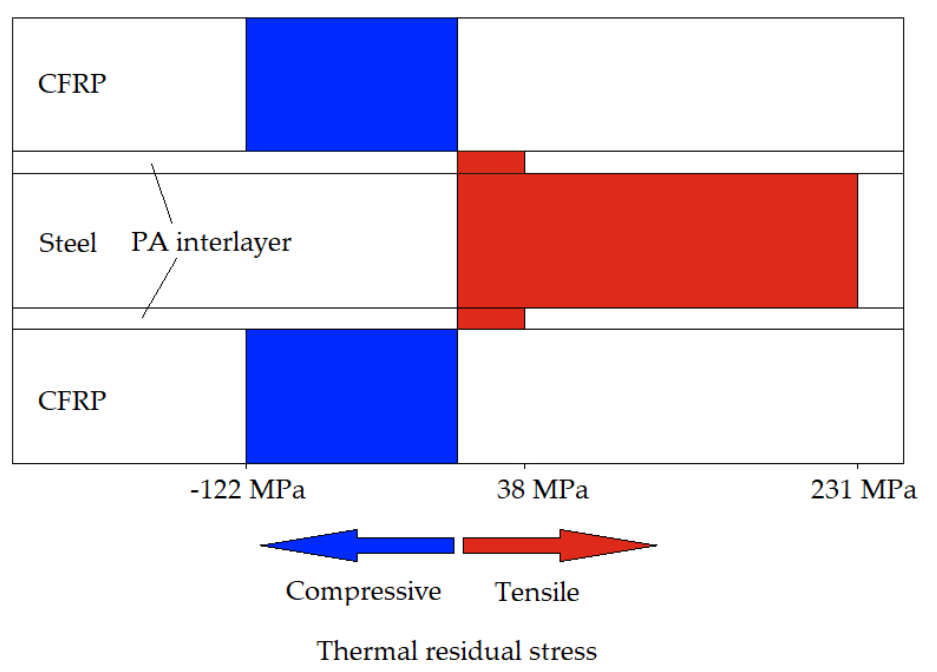
Figure 14. Exemplary visualization of the calculated thermal residual stress (numerical simulation with orthotropic material model) in the investigated hybrid laminate.